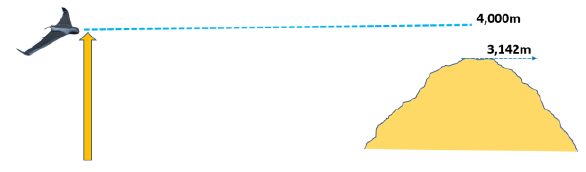
Figure 5. Second flight mission